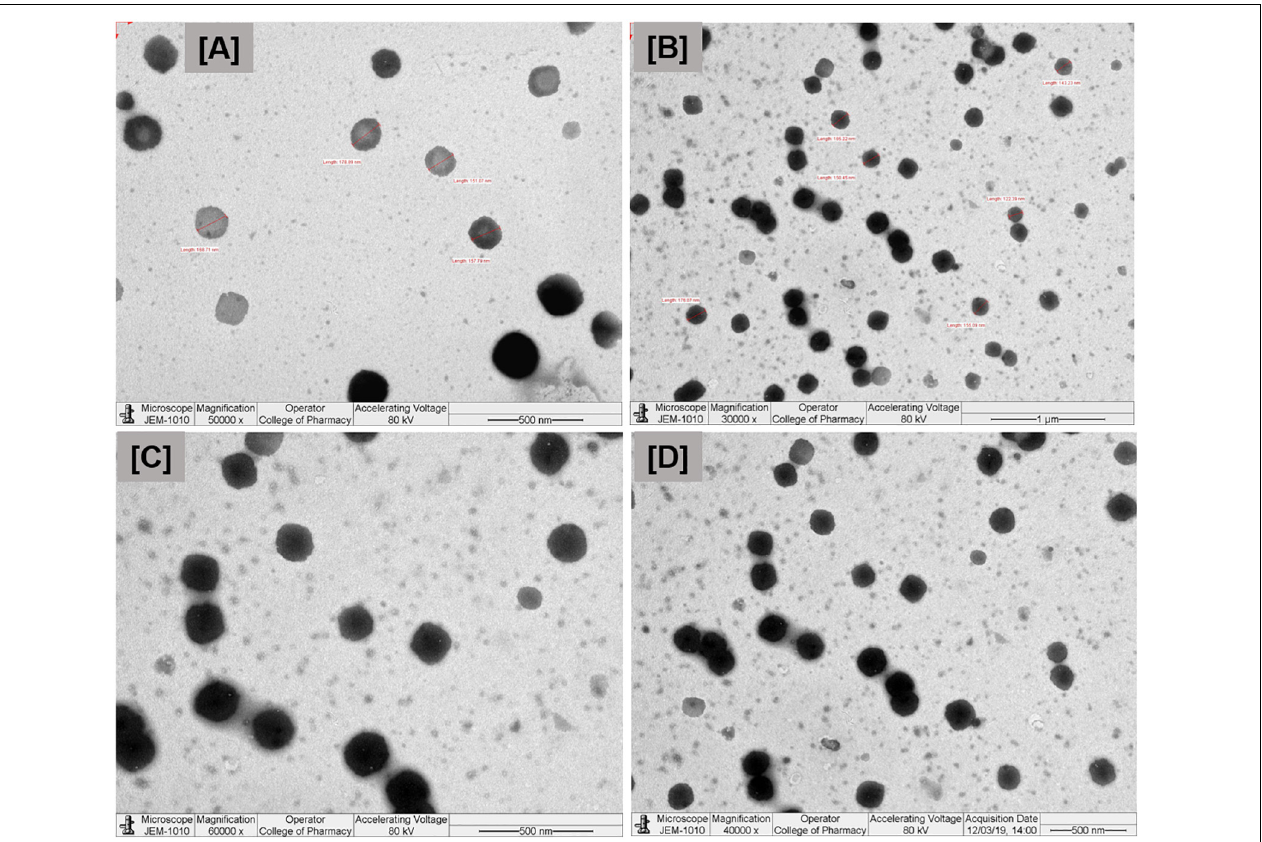
Table 3 . Solubility studies clearly indicated that TAL has high solubility in the formulations containing higher fatty acids. The solubility was also higher in Types IIIB and IV formulations (hydrophilicity increased). Amongst the various formulations, F1, F2, F6, AF6, and AF7 were found to solubilize higher amounts of TAL. The drug loading was found to be comparatively higher in the formulations containing fatty acid (F1) and water soluble cosolvent